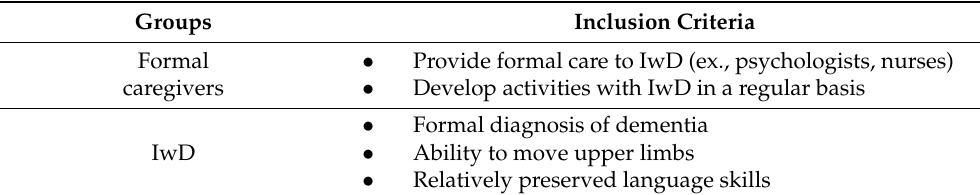
Table 1. Inclusion criteria according to the sample